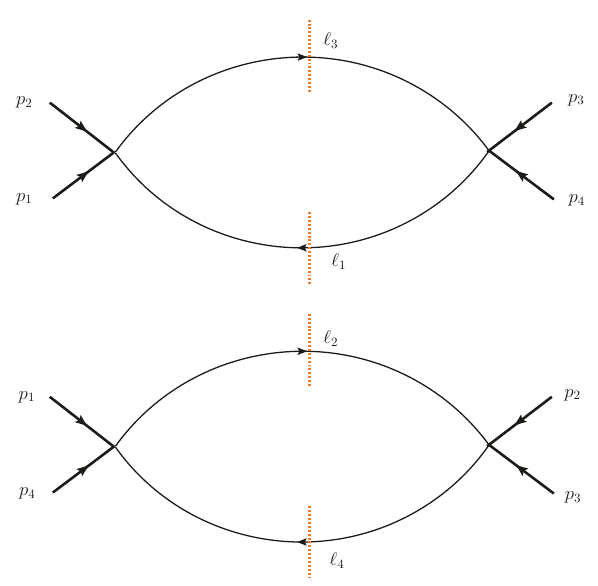
Figure 3 . Two-particle cut diagrams for the all-plus amplitude discussed in the text. Bold external lines represent physical gluons or gravitons, depending on the context. There are a total of six different